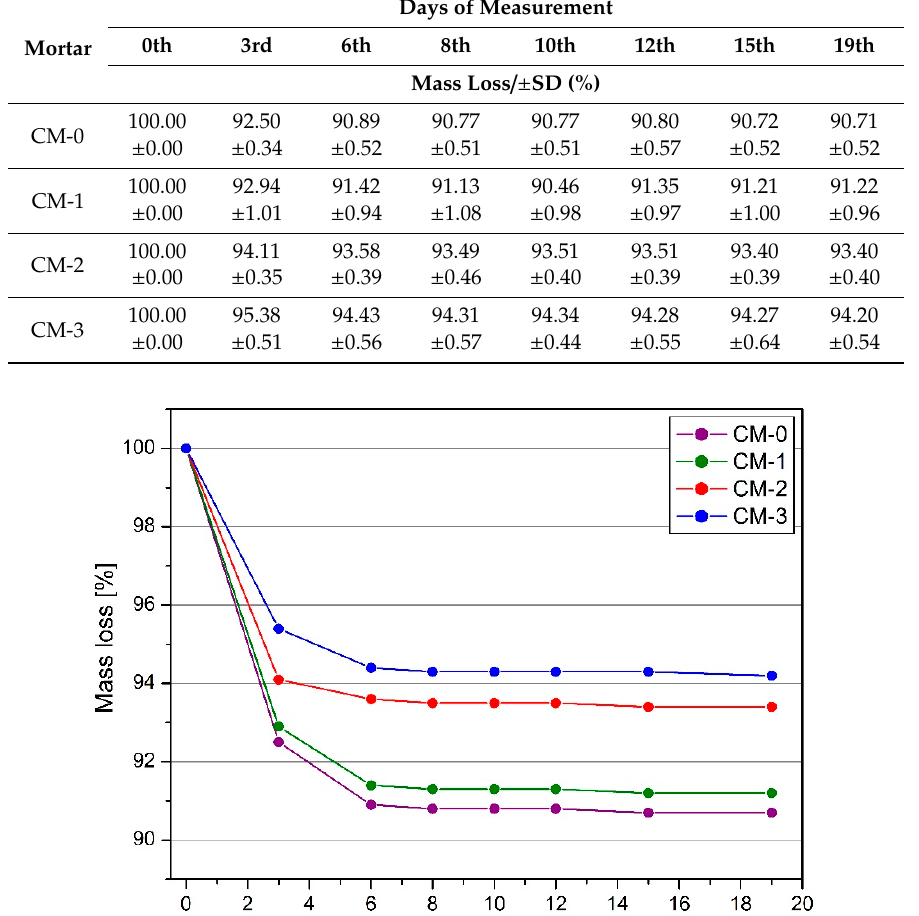
Figure 8. Flexural strength of tested mortars.